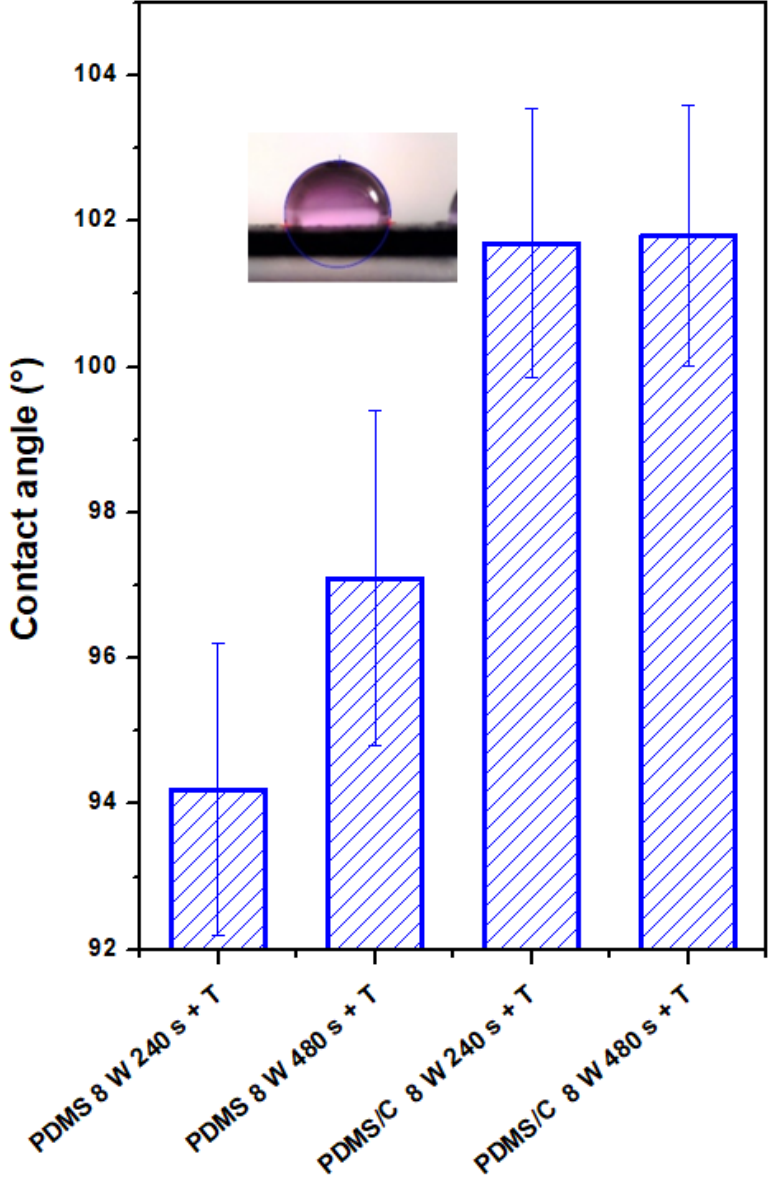
Figure 4. Contact angles of wettability of plasma-modified and thermally stressed PDMS films, two different exposure powers (3 and 8 W), and exposure times (240 and 480 s) were used.